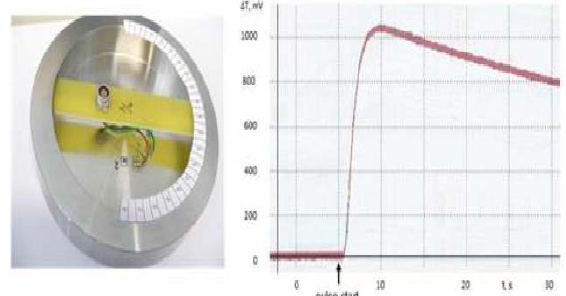
Fig. 2. Test mirror with PT-100 detectors (left) and meas- ured temperature sequence of the central PT-100 detector (right).